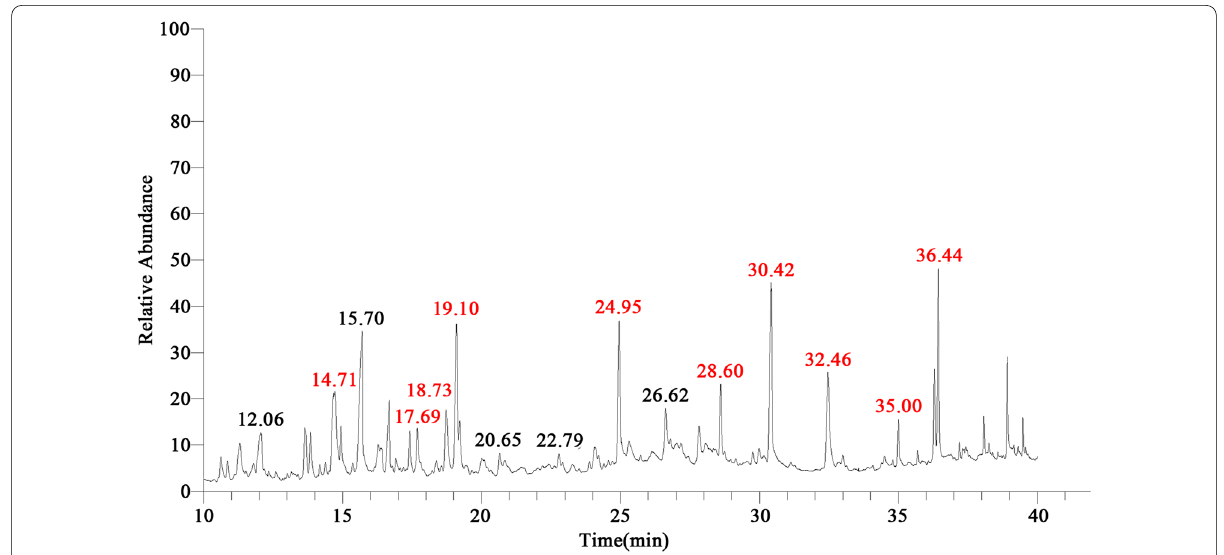
Fig. 3 The representative TIC of chestnut bur